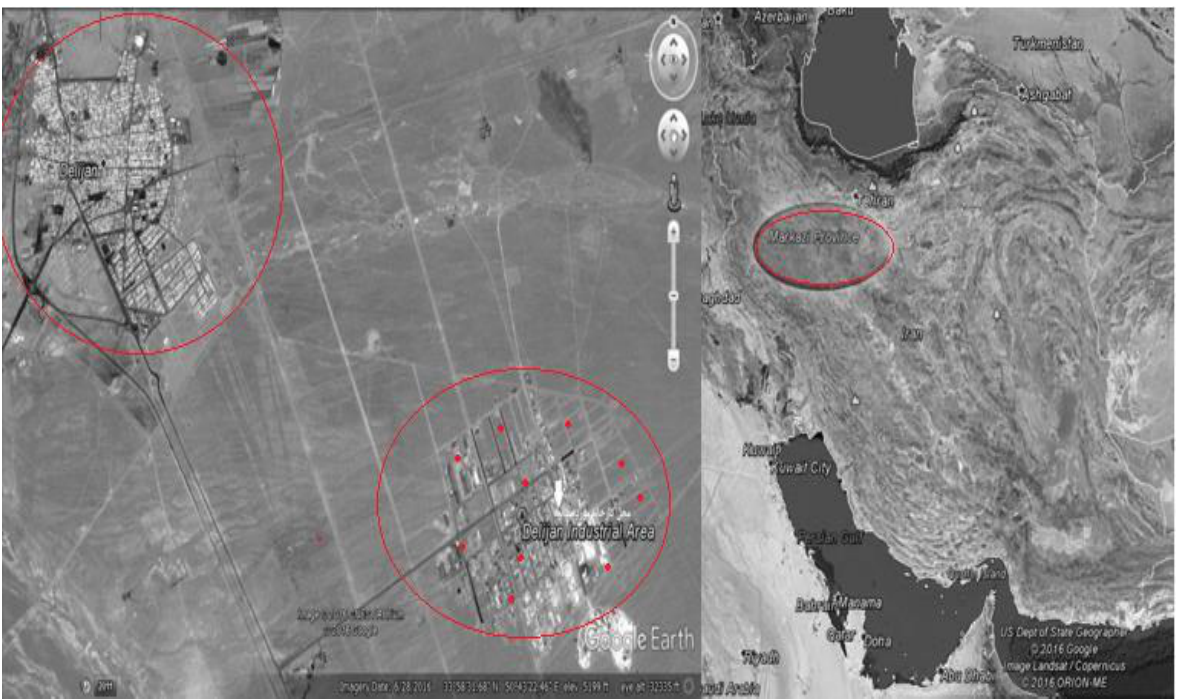
Figure 1. Location of in Industrial Town Delijan, Delijan city, Markazi